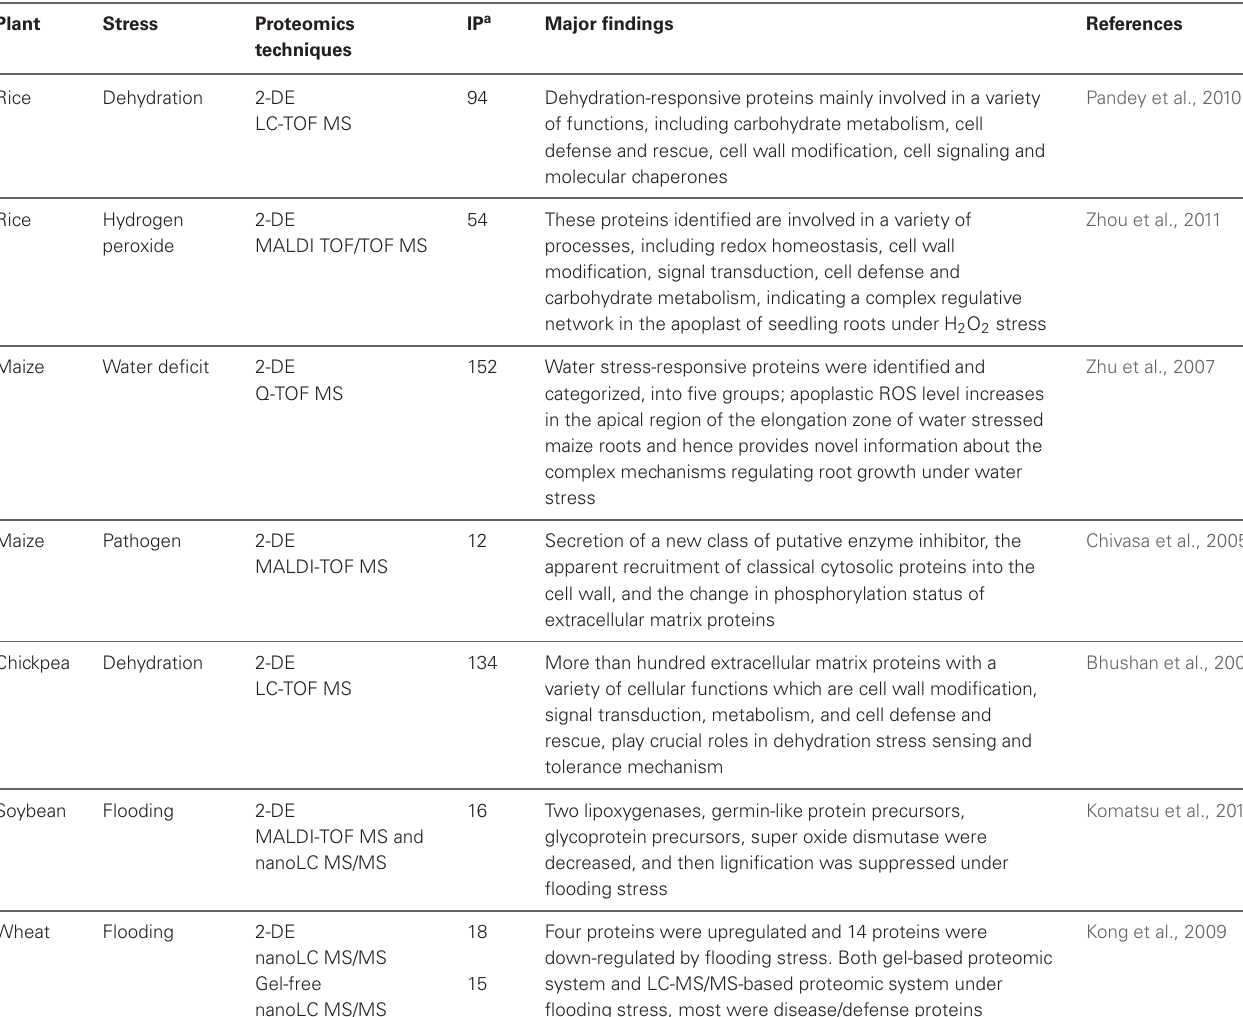
Table 1 | Summary of published cell wall proteomics analyses in response to environmental stress.